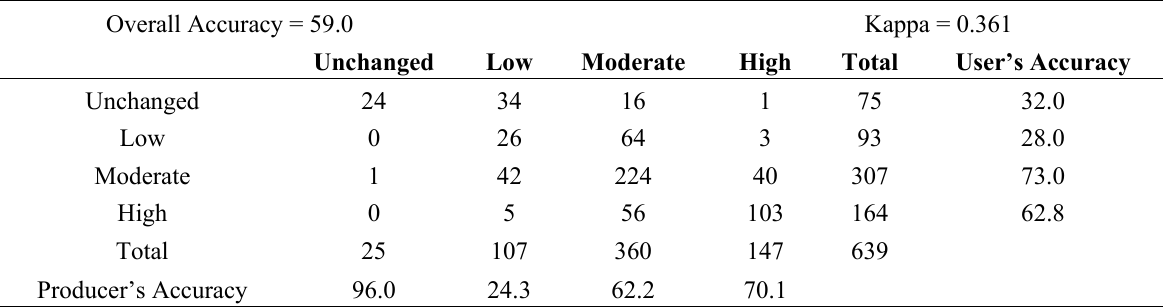
Table 9. Confusion matrix for field data (columns) and dNBR pixel values (rows).